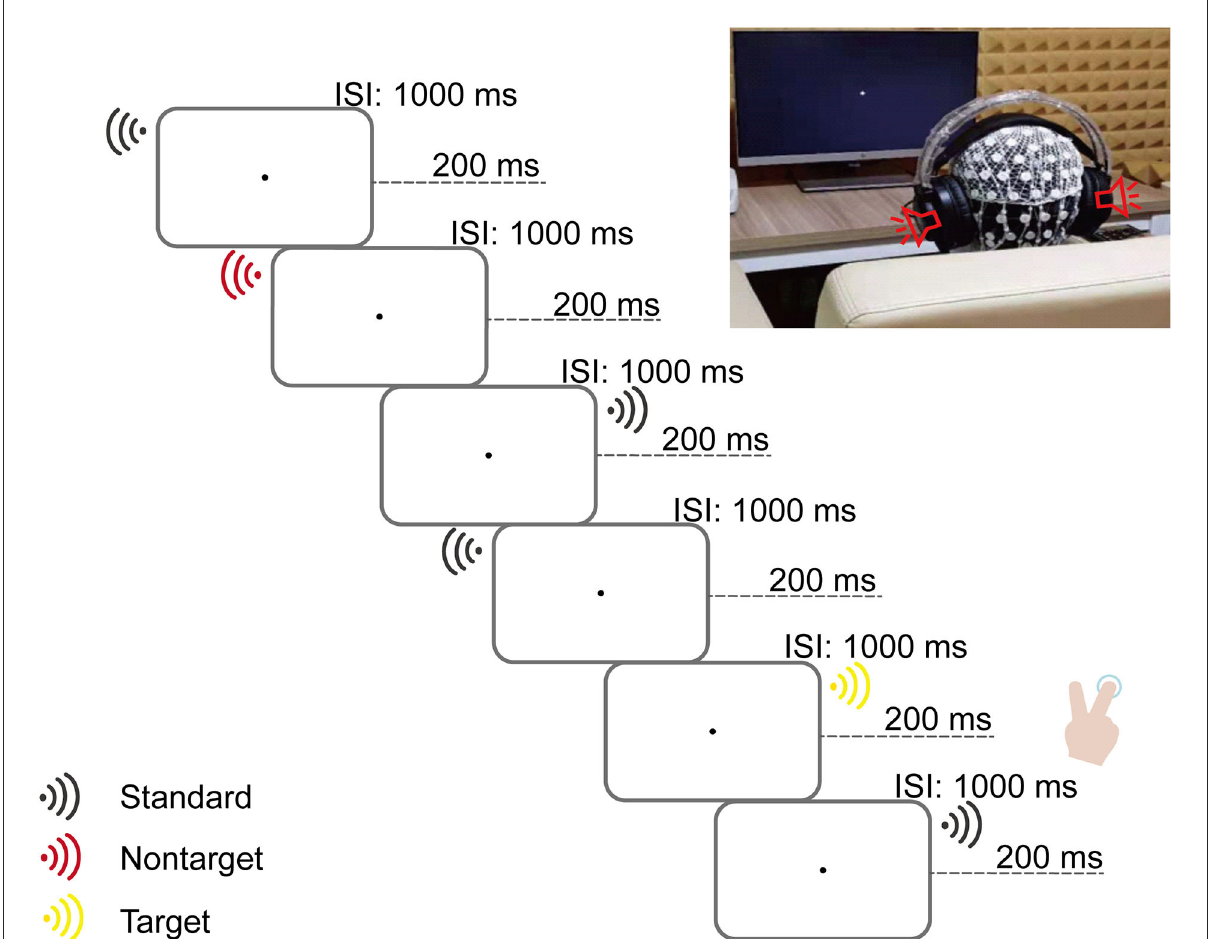
FIGURE1 Illustration of a typical sequence of stimuli and a scene of a real experiment. In the (Left) panel, the flowchart shows a slice of the stimulus sequence. One stimulus was pseudorandomly played at a time in mono via a headphone (either the right or left side). Three types of stimuli were defined: target deviants (16.3% occurrence, 240 trials divided evenly on both sides) and unattended deviants (16.3% occurrence, 240 trials divided evenly on both sides) counterbalanced with the two tones (200 and 1,000Hz) between subjects and non-target standards (67.4% occurrence, 992 trials divided evenly on both sides). Each trial with a duration of 1,200ms consisted of one stimulus played for 200ms, followed by an interstimulus interval (ISI) of 1,000ms. In the (Right) panel, children were instructed to keep their eyes on the fixation point on a computer screen; meanwhile, they were instructed to determine the side of the target deviants (pressing the button “2” or “3” on the keyboard with the index or middle finger of the right hand if the target deviants played on the left or right side) as accurately and quickly as possible and ignore the other